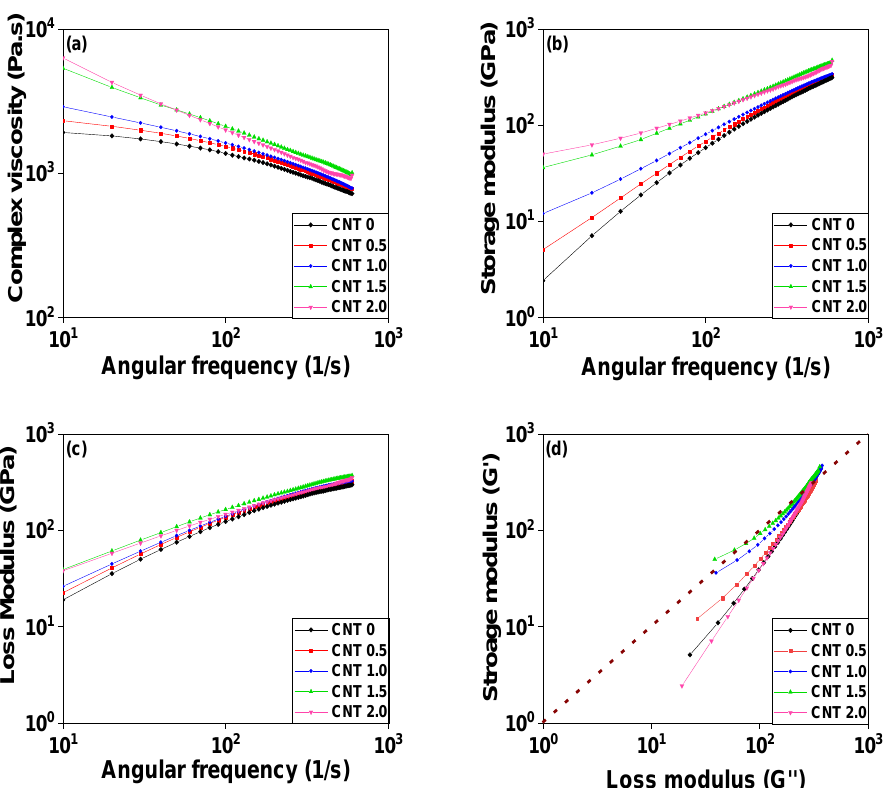
Figure 7. Rheological properties of the POM/CNT nanocomposites: ( a ) complex viscosity; ( b ) shear storage modulus ( G’ ); ( c ) shear loss modulus ( G” ) as a function of frequency; ( d ) G’ vs. G”. The POM/CNT nanocomposite with 1.5 wt% CNT loading (POM/C1.5) was chosen as the reference material because of its enhanced electrical, thermal, mechanical, and rhe- ological properties. The ethylene-co-acid-co-sodium acid copolymer-based ionomer and cyanuric acid were utilized to adjust the surface resistance and its monodispersity of the POM/C1.5 nanocomposite as shown in Figure 8. The incorporation of the ionomer re- duced the surface resistances of the composites, reaching a minimum at 3.0 wt% loading (POM/C1.5/I3) (Figure 8a). Cyanuric acid loading only slightly influenced the mean sur- face resistance of the nanocomposites (Figure 8b), with a loading of 0.5 wt% (POM/C1.5/A0.5) having the lowest surface resistance polydispersity. The surface re- sistance polydispersity as well as the mean surface resistance are crucial for antistatic and dissipative properties, especially for electronic device-fixing jigs. The combination of ion- omer (3 wt%) and cyanuric acid (0.5 wt%) led to the lowest surface resistance with mon-